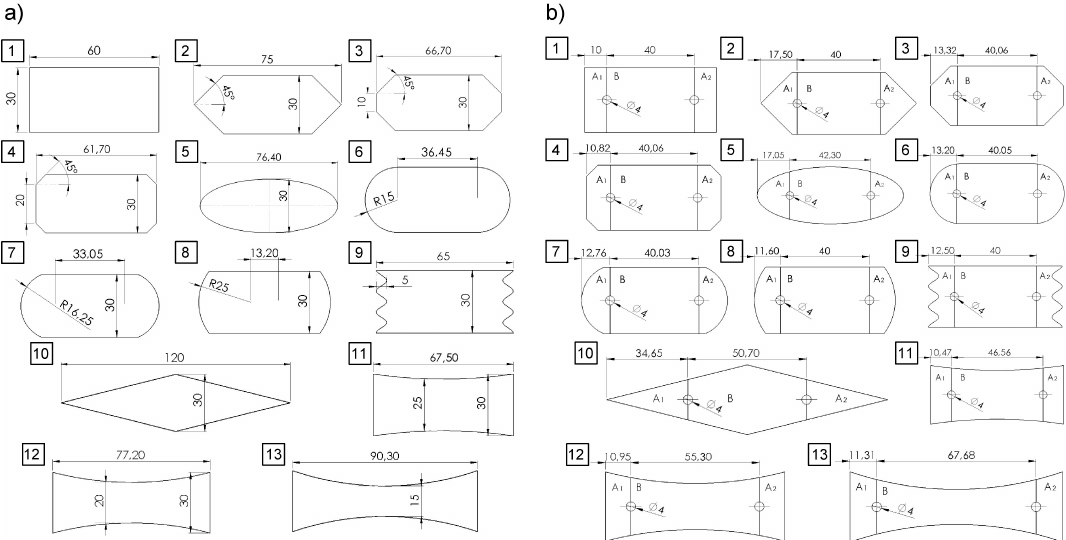
Figure 1. Lap shapes: ( a ) Pure adhesive models, ( b ) hybrid joints. (Length in mm; angle in degree).